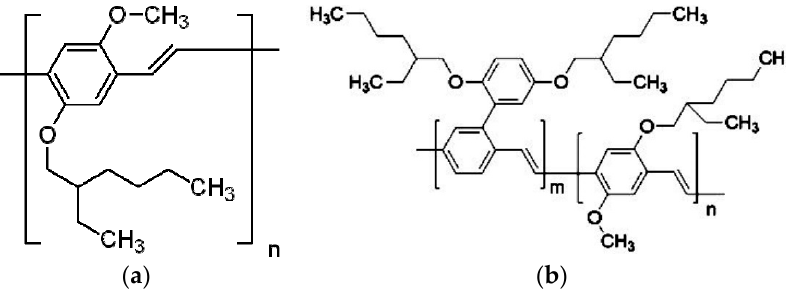
Figure 1. ( a ) Molecular structures of MEH–PPV; ( b ) molecular structures of BEHP- co -MEH–PPV (BMP).